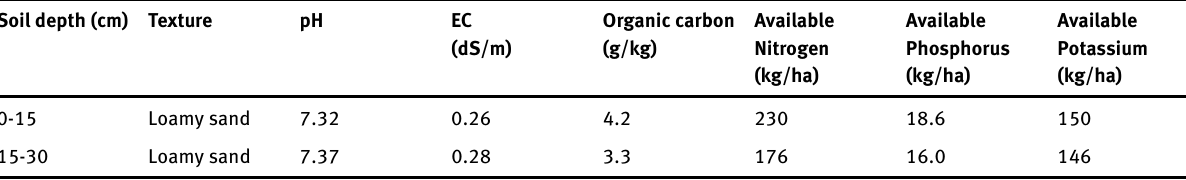
Table 1: Physico-chemical characteristics of the experimental soil Soil depth (cm)